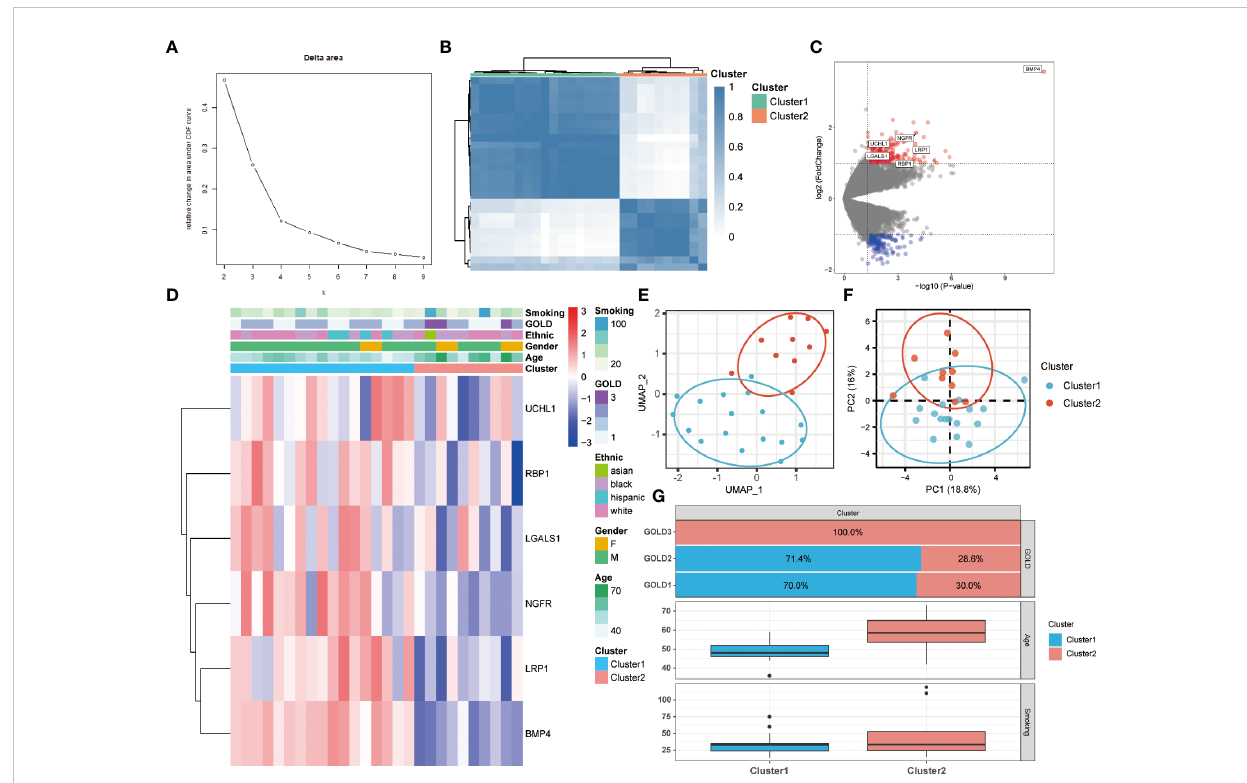
FIGURE 2 Two different anoikis-related subtypes identi fi ed in COPD by consistent clustering of 25 ANRGs. (A) Comparison of the relative change in area under the cumulative distribution function (CDF) curves when the cluster number shifting from k to k+1. The k value was adjusted between 2 and 10, and the optimal k was set at 2. (B) Heatmap of the matrix of co-occurrence proportions for COPD samples. (C) The volcano plot showed DEGs between Cluster1 and Cluster2. Red indicated upregulated genes, while blue indicated downregulated genes. Genes with no signi fi cant difference were marked in grey. (D) The relative expression of six differentially expressed ANRGs between Cluster1 and Cluster2 was shown in the composite heatmap. Red indicated high expression of ANRGs in Cluster1, while blue indicated low expression of ANRGs in Cluster1. (E, F) The UMAP and PCA plots validated the two unique patterns in COPD. Two distinct subgroups were identi fi ed, demonstrating that Cluster1 and Cluster2 samples could be clearly discriminated based on their respective ANRGs expression pro fi les. (G) Correlation of the anoikis pattern with clinical characteristics. The histogram for the categorical variable was utilized to depict the distribution of COPD patients in each cluster at the various GOLD stages. The histogram for continuous variables was used to compare differences in age and smoking cigarettes among COPD patients between the two